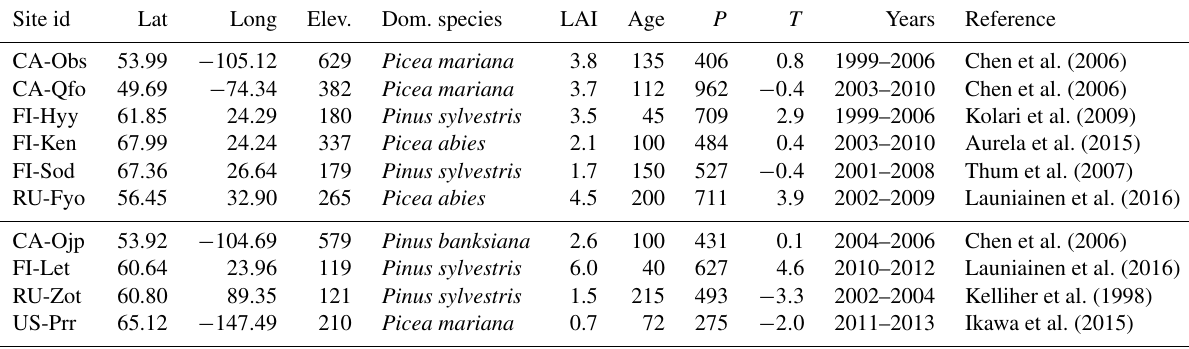
Table 1. Descriptions for the sites used in this study sorted by their FLUXNET identifier. The first six sites are used for both calibration and validation purposes, with the first 5 years of each site used for calibration. The last 3 years as well as the last four sites are used for validation only. The reported elevation is in metres above sea level, LAI is the one-sided leaf area index, and the average stand age is in years, along with average annual precipitation ( P ) in millimetres and temperature ( T ) in degrees